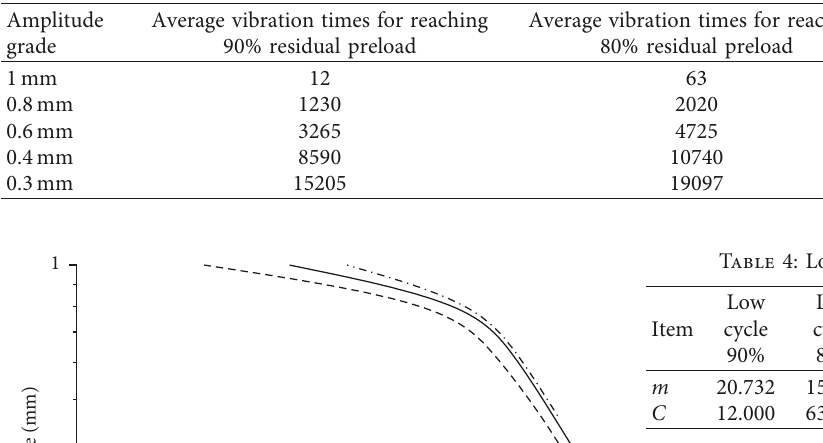
Table 3: Loosening vibration times of each amplitude grade.